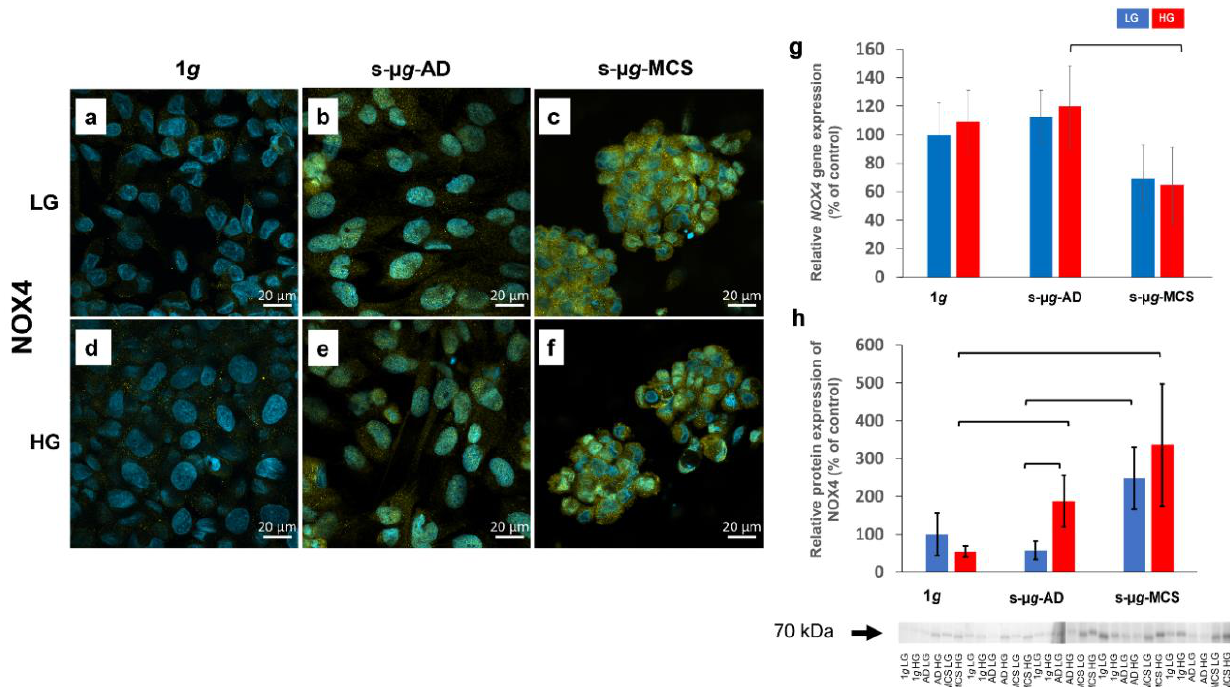
Figure 6. Analysis of NOX4 after 14 days of cultivation either at 1 g or s-µ g and either using low (LG) or high (HG) glucose medium. Data were obtained via immunostaining ( a – f ), qPCR ( g ), and Western blot ( h ) techniques. The bracket stands for a significance level of p < 0.05.